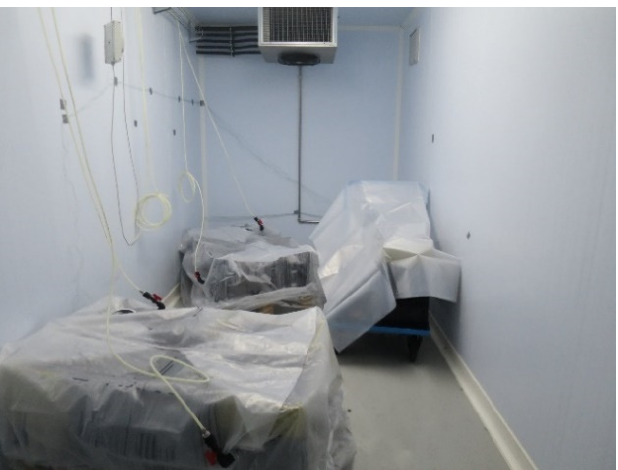
Figure 2. LDPE plastic bag cover of controlled atmosphere treatments and connection to the GAC 5000 unit for gas monitoring and control.